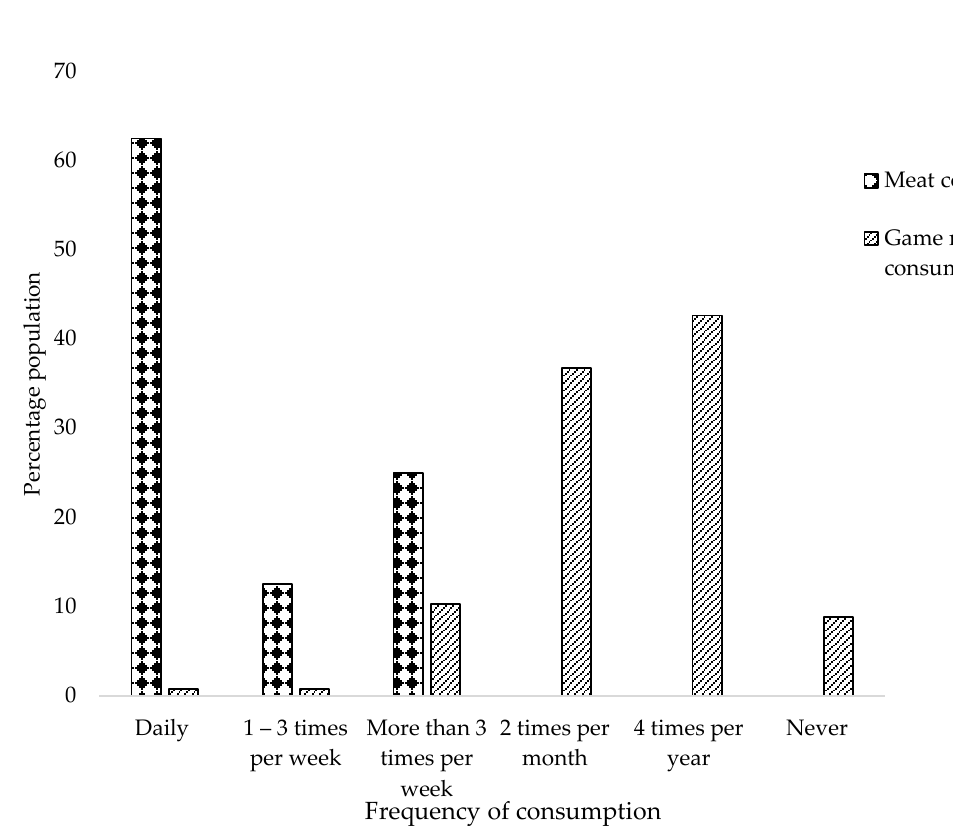
Figure 2. Meat consumption behaviour within the sample population. Table 6. Least significant means ( ± SE) of the preference and factors influencing the purchase of game meat products within the sample